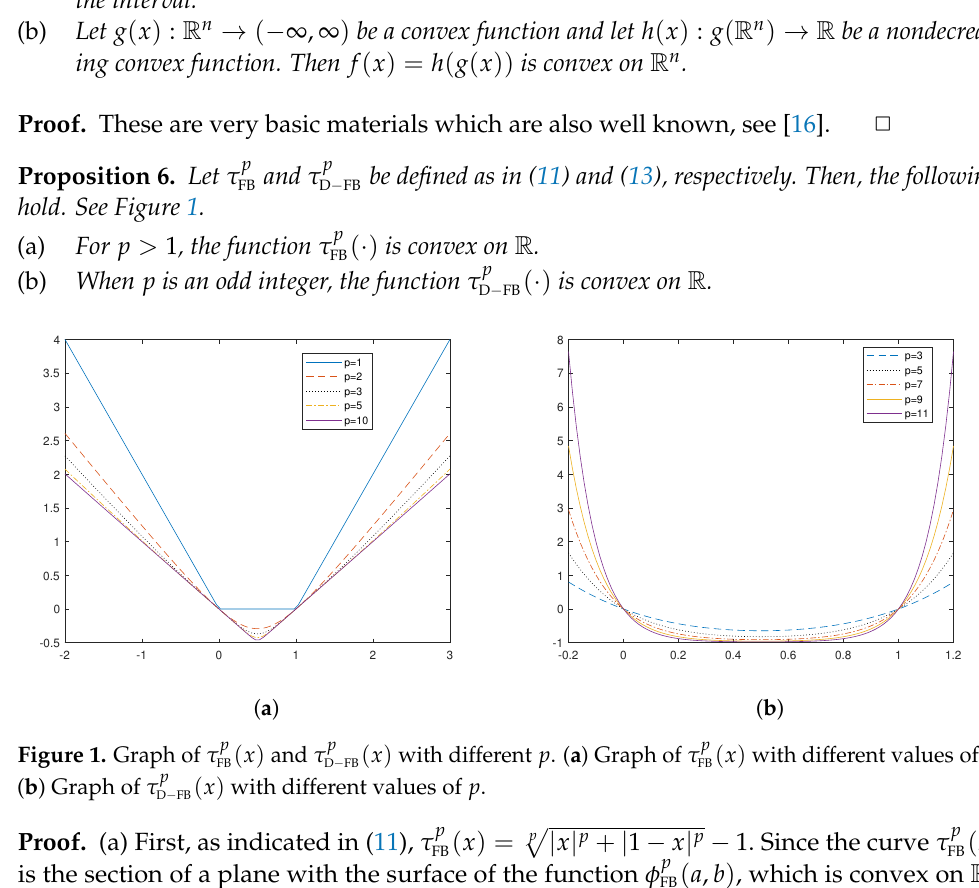
with different values of p FB